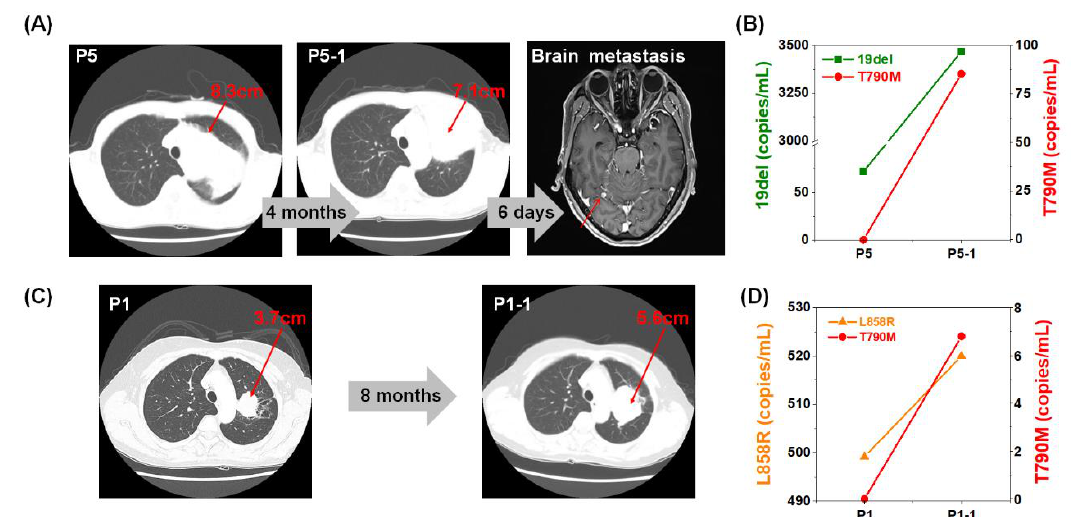
Figure 4. Monitoring of lung cancer patients via CT scan image and molecular analysis of EGFR mutations by ddPCR of BW-derived EV-DNA. ( A ) The size of the tumor decreased from 8.3 (P5) to 7.1 cm (P5-1) after about four months. However, a new metastasized lesion was found in the brain. ( B ) 19del EGFR mutation was increased and T790M EGFR mutation was emerged. ( C ) The tumor size increased from 3.7 to 5.6 cm after eight months of TKI therapy. ( D ) The L858R EGFR mutation was also increased, and T790M EGFR mutation emerged from ddPCR results of BW-derived EV-based liquid biopsy.